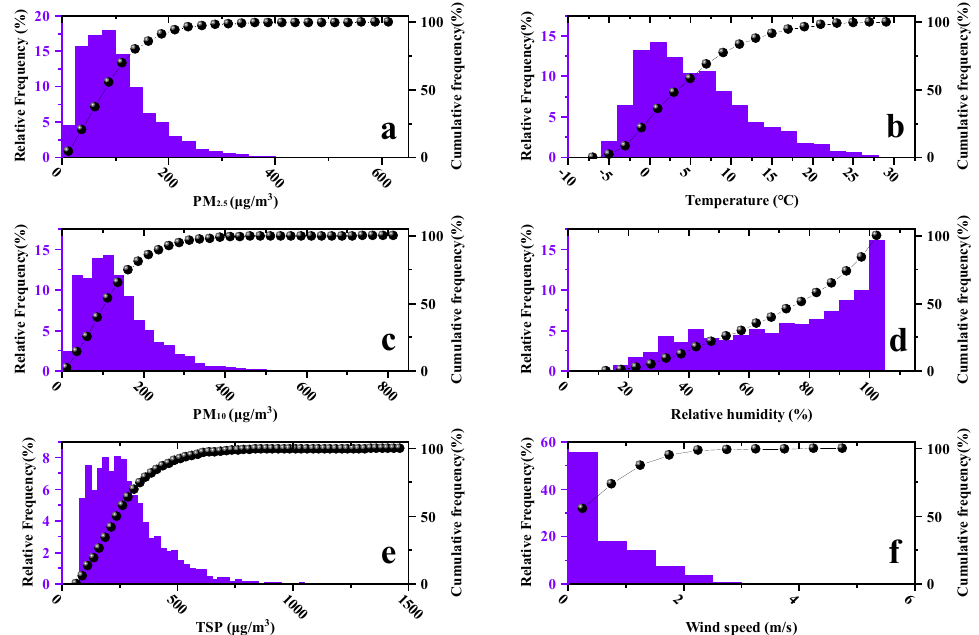
Figure 4. Relative and cumulative frequency distributions of the variables over the entire experi- mental period: ( a ) PM 2.5 ; ( b ) Temperature; ( c ) PM 10 ; ( d ) Relative Humidity; ( e ) TSP; ( f ) Wind speed.